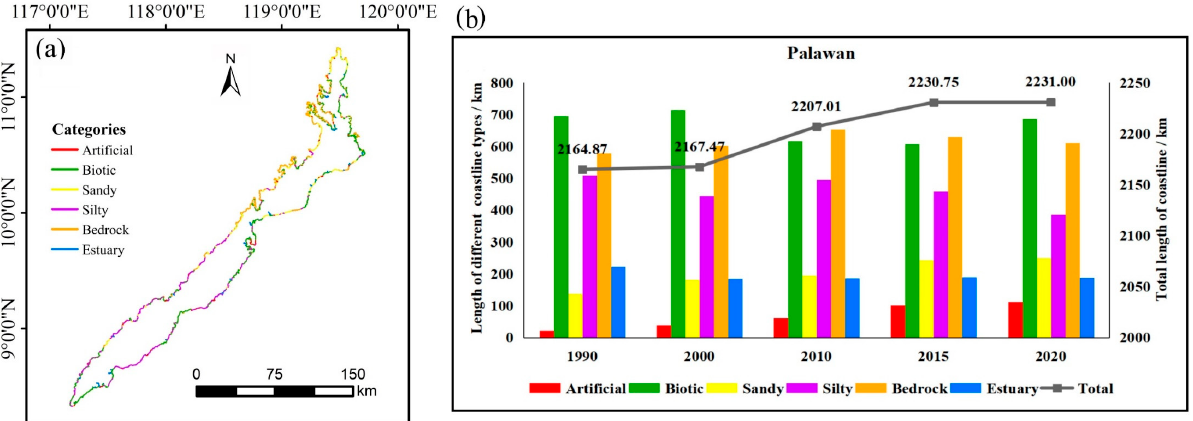
Figure 9. The coastline of Timor Island. ( a ) Spatial distributions of coastline in 2020 and ( b ) length statistics of different coastline types from 1990 to 2020.